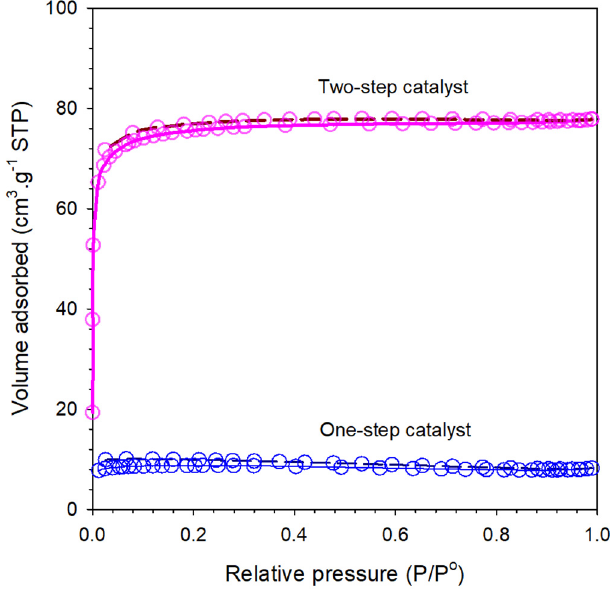
Figure 4. Plots of N 2 isotherm data of the one-step catalyst and two-step catalyst xerogels calcined at 175 °C. Table 3. Surface properties of the organo-silica